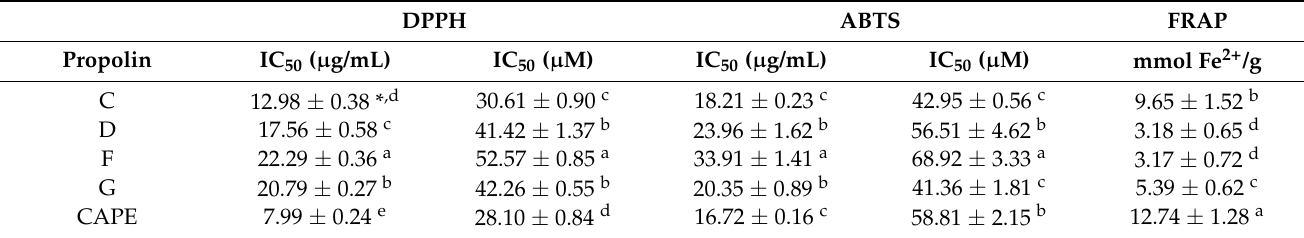
Table 5. Antioxidant activity of